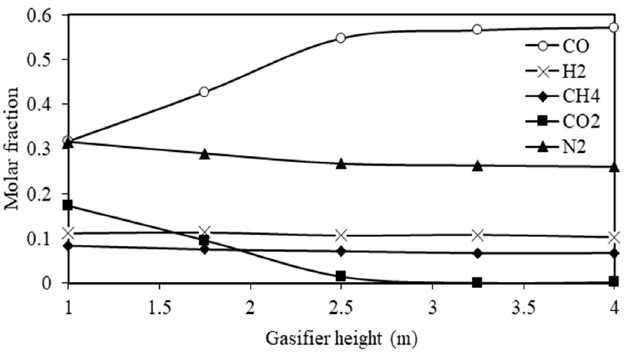
Figure 6. Gas composition along the gasifier height.